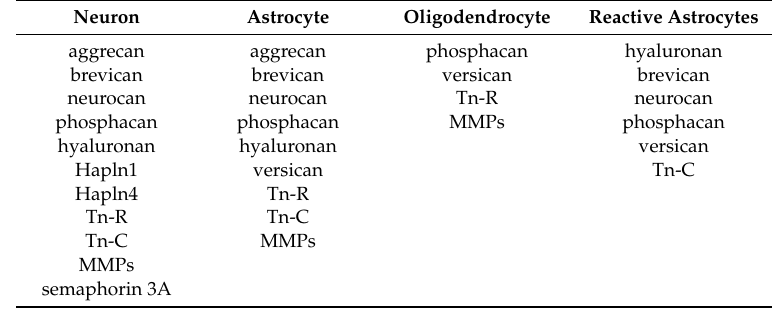
Table 2. Glycosaminoglycans (GAGs) composition. GAGs can contain galactose (Gal) or Uronic